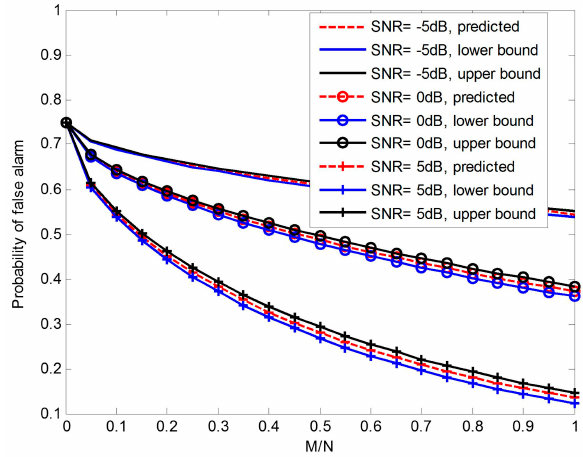
p at several different SNR (signal to noise ratio) levels